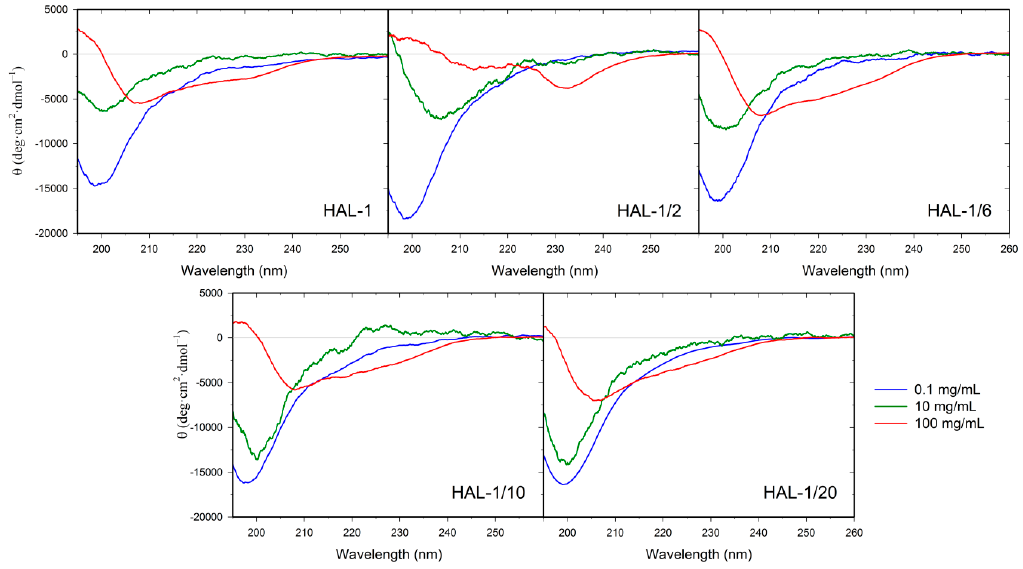
Figure 9. Concentration dependence of ECD spectra of HAL-1 and its analogs: 0.1, 10, 100 mg/mL.